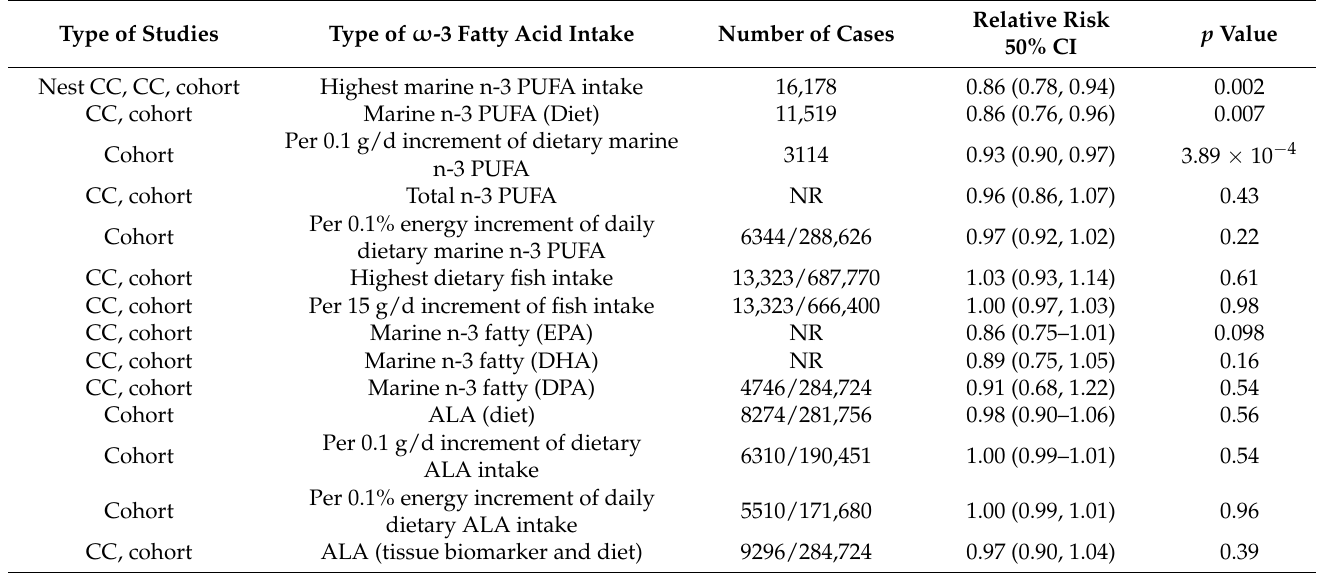
Table 5. Meta-analyses of fish and ω 3 fatty-acid intake and breast cancer risk according to re-analyses of